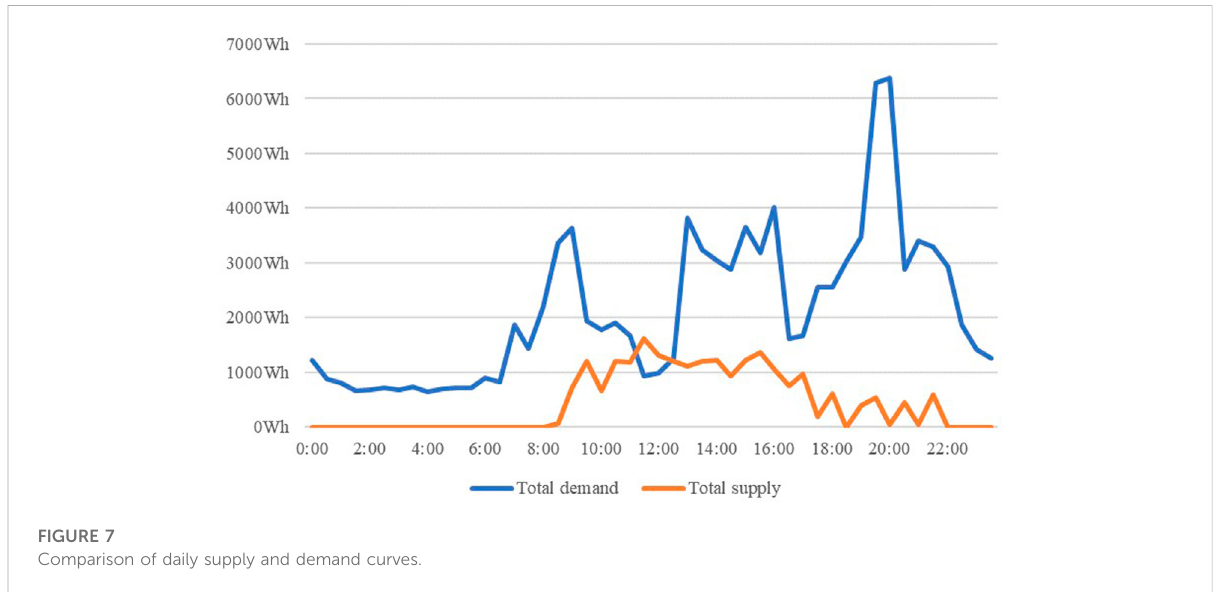
FIGURE 7 Comparison of daily supply and demand curves.